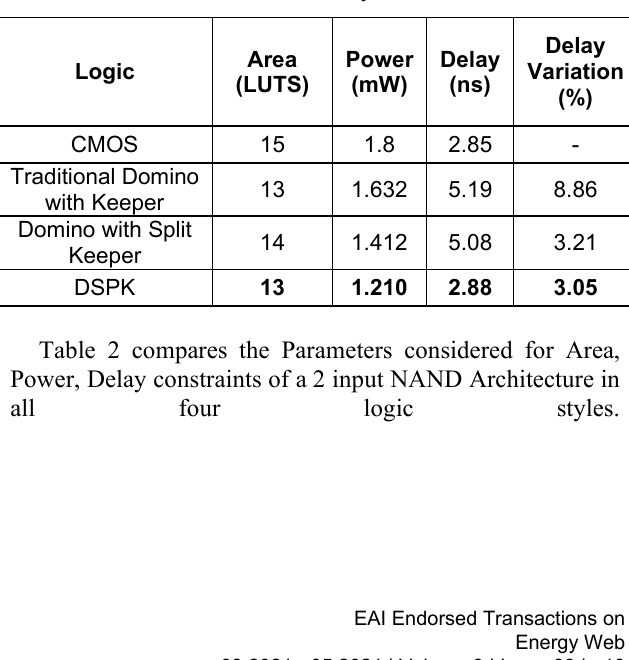
Table 1. Circuit Analysed: